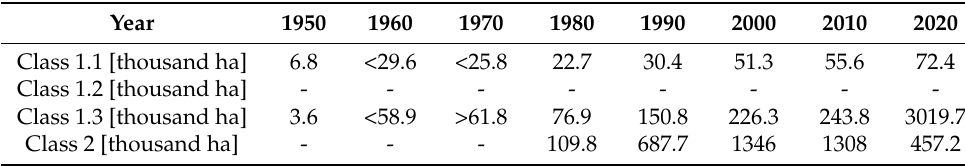
Table 4. Protected forests (FOREST EUROPE Classes) in Poland